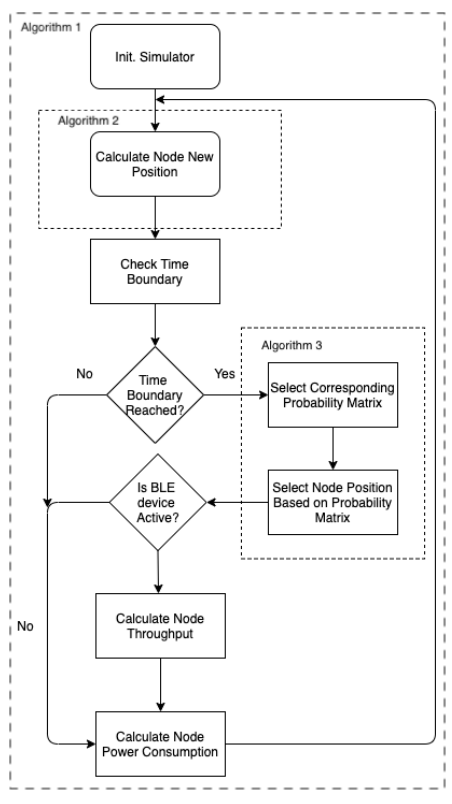
Figure 11. Simulator algorithm flow